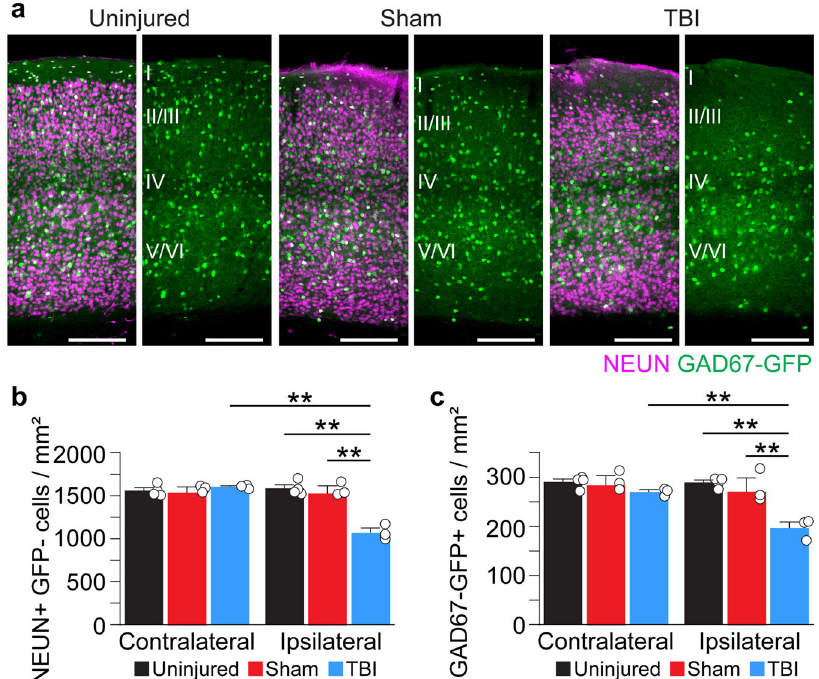
Fig. 4 Chronic neuron loss in V1 after TBI. a Coronal images of control, sham and CCI-injured V1 labeled for NEUN (magenta) and GAD67-GFP (green) 3 months after TBI. b Quanti fi cation of NEUN + /GFP- cell density in control, sham, and brain-injured mice 3 months after CCI. ** P = 1.33E-06, ipsilateral control versus ipsilateral TBI, ** P = 4.23E-06, ipsilateral sham versus ipsilateral TBI, ** P = 1.99E-06, ipsilateral TBI versus contralateral TBI; two-way ANOVA with Tukey ’ s post hoc test, N = 3 – 4 mice per group. c Quanti fi cation of GAD67-GFP + cell density in control, sham, and brain-injured mice 90 d after CCI. ** P = 1.60E-04, ipsilateral control versus ipsilateral TBI, ** P = 1.02E-03, ipsilateral sham versus ipsilateral TBI, ** P = 2.96E-03, ipsilateral TBI versus contralateral TBI; two-way ANOVA with Tukey ’ s post hoc test, N = 3 – 4 mice per group. Scale bar, 500 μ m; error bars, SEM. See Supplementary Data 3 for statistical